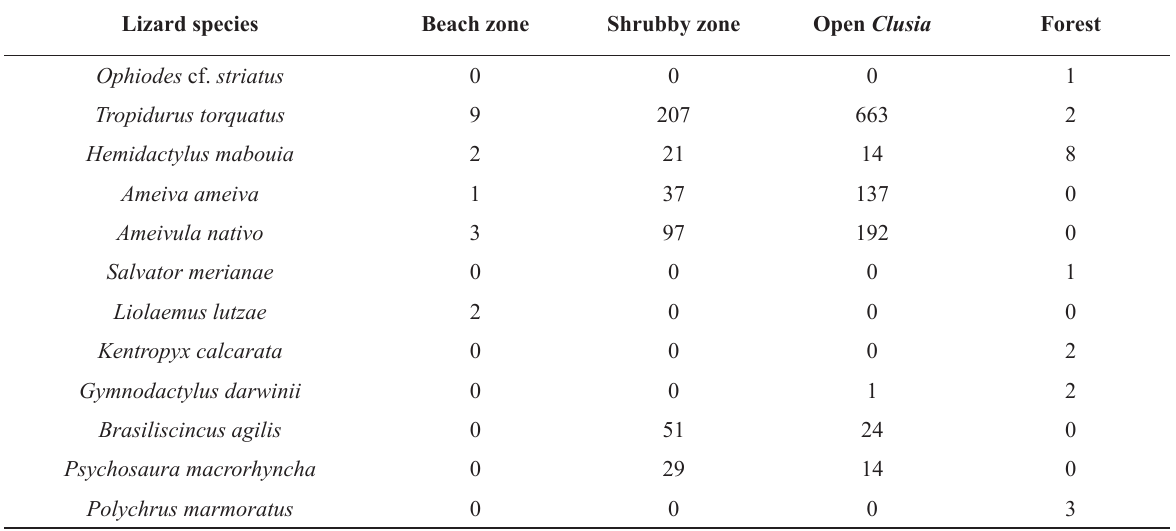
Abundance of each lizard species using the different mesohabitats at: Praia das Neves, Paulo Cesar Vinha State Park, Conceição da Barra Environmental Protection Area, Comboios Biological Reserve and Itaúnas State Park. Lizard species Beach zone Shrubby zone Open Clusia Forest Ophiodes cf. striatus Tropidurus